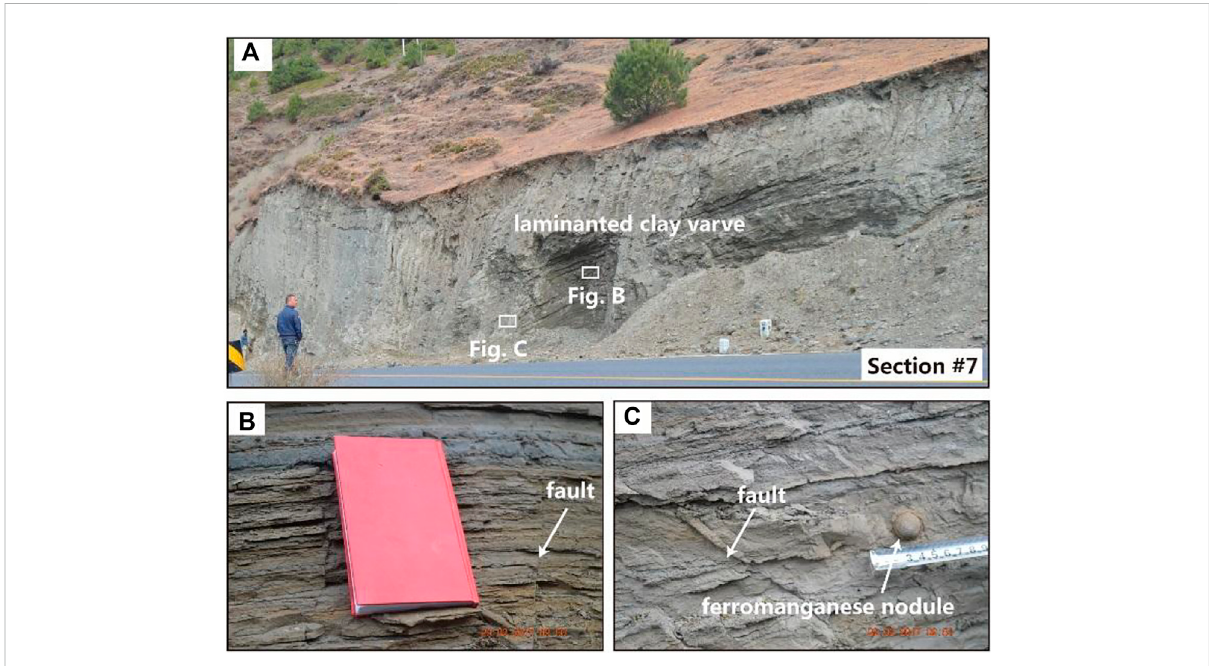
FIGURE 6 Macroscopic and detailed sedimentary characteristics of section #7, mainly including soft-sediment deformation structures. (A) Panorama picture of section #7. (B) Close-up photograph of clay lamination in section #7. (C) Close-up photograph of ferromanganese nodules in section